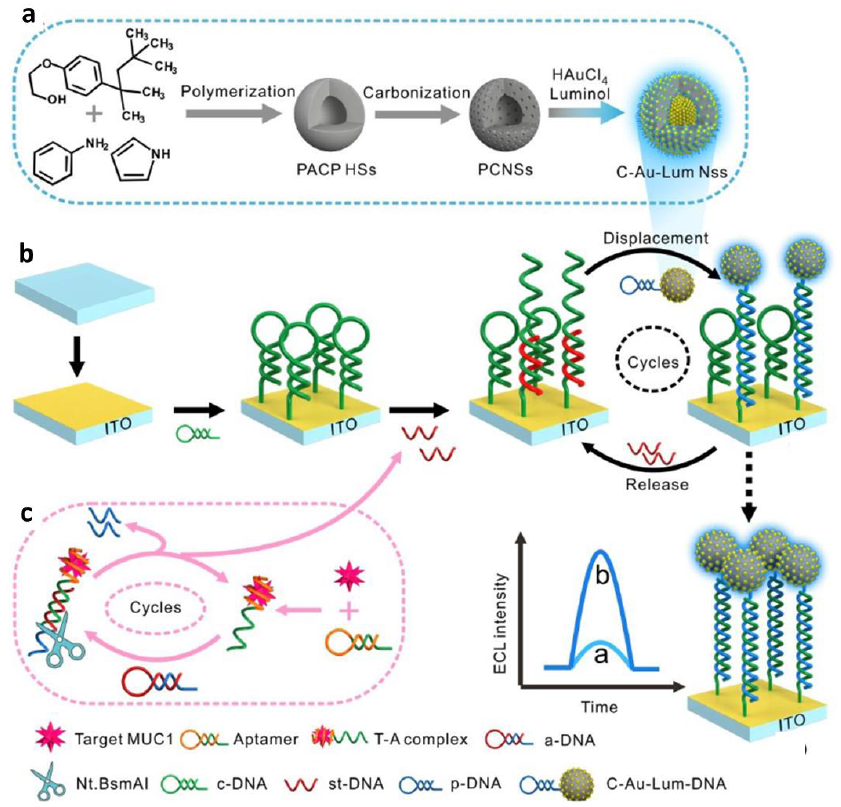
Figure 6. Schematic Illustration of ECL biosensor fabrication and MUC1 detection. ( a ) Design and fabrication of novel luminescent materials denoted as C − Au − luminol nanospheres. ( b ) Fabrication of the biosensor and the strain displacement circulation for MUC1 target detection. ( c ) MUC1 recognition and Nt.BsmAI−assisted recycling amplification process. Adapted with permission from [57] . Copyright 2019, Royal Society of Chemistry.